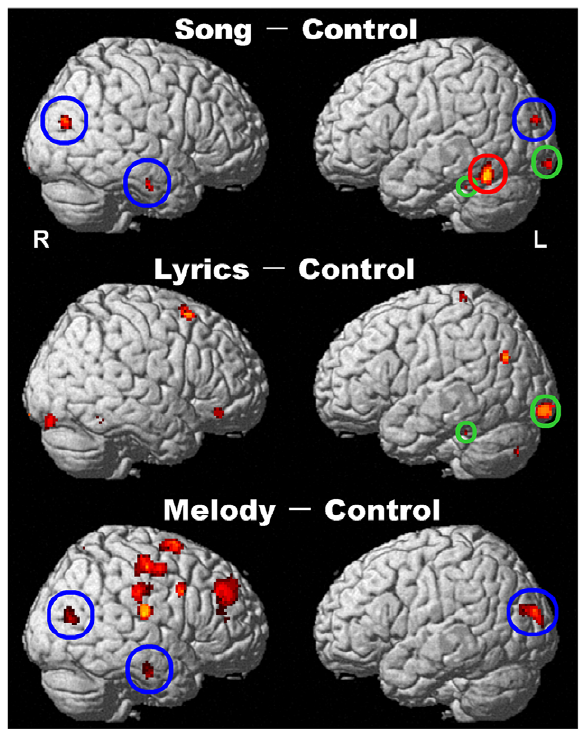
Figure 4. The regions activated by each familiarity decision task (Song, Lyrics, or Melody) compared to the Control task (p , 0.005, uncorrected, with multiple-comparison correction, cluster size . 20 voxels). As per conjunction analysis, a red circle represents specific activation for Song (Song–Lyrics > Song–Melody > Song–C); a green circle represents regions activated by both Song and Lyrics (Song–C > Lyrics–C); a blue circle represents regions activated by both Song and Melody (Song–C >